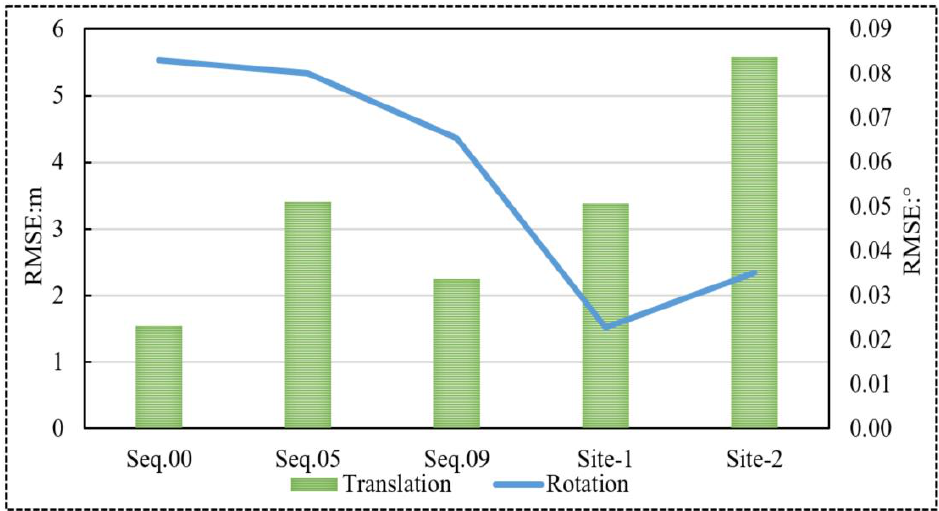
Figure 9. The root mean square error (RMSE) of absolute trajectory translation and rotation. Bar graph represents absolute translation error, line graph represents absolute rotation error.